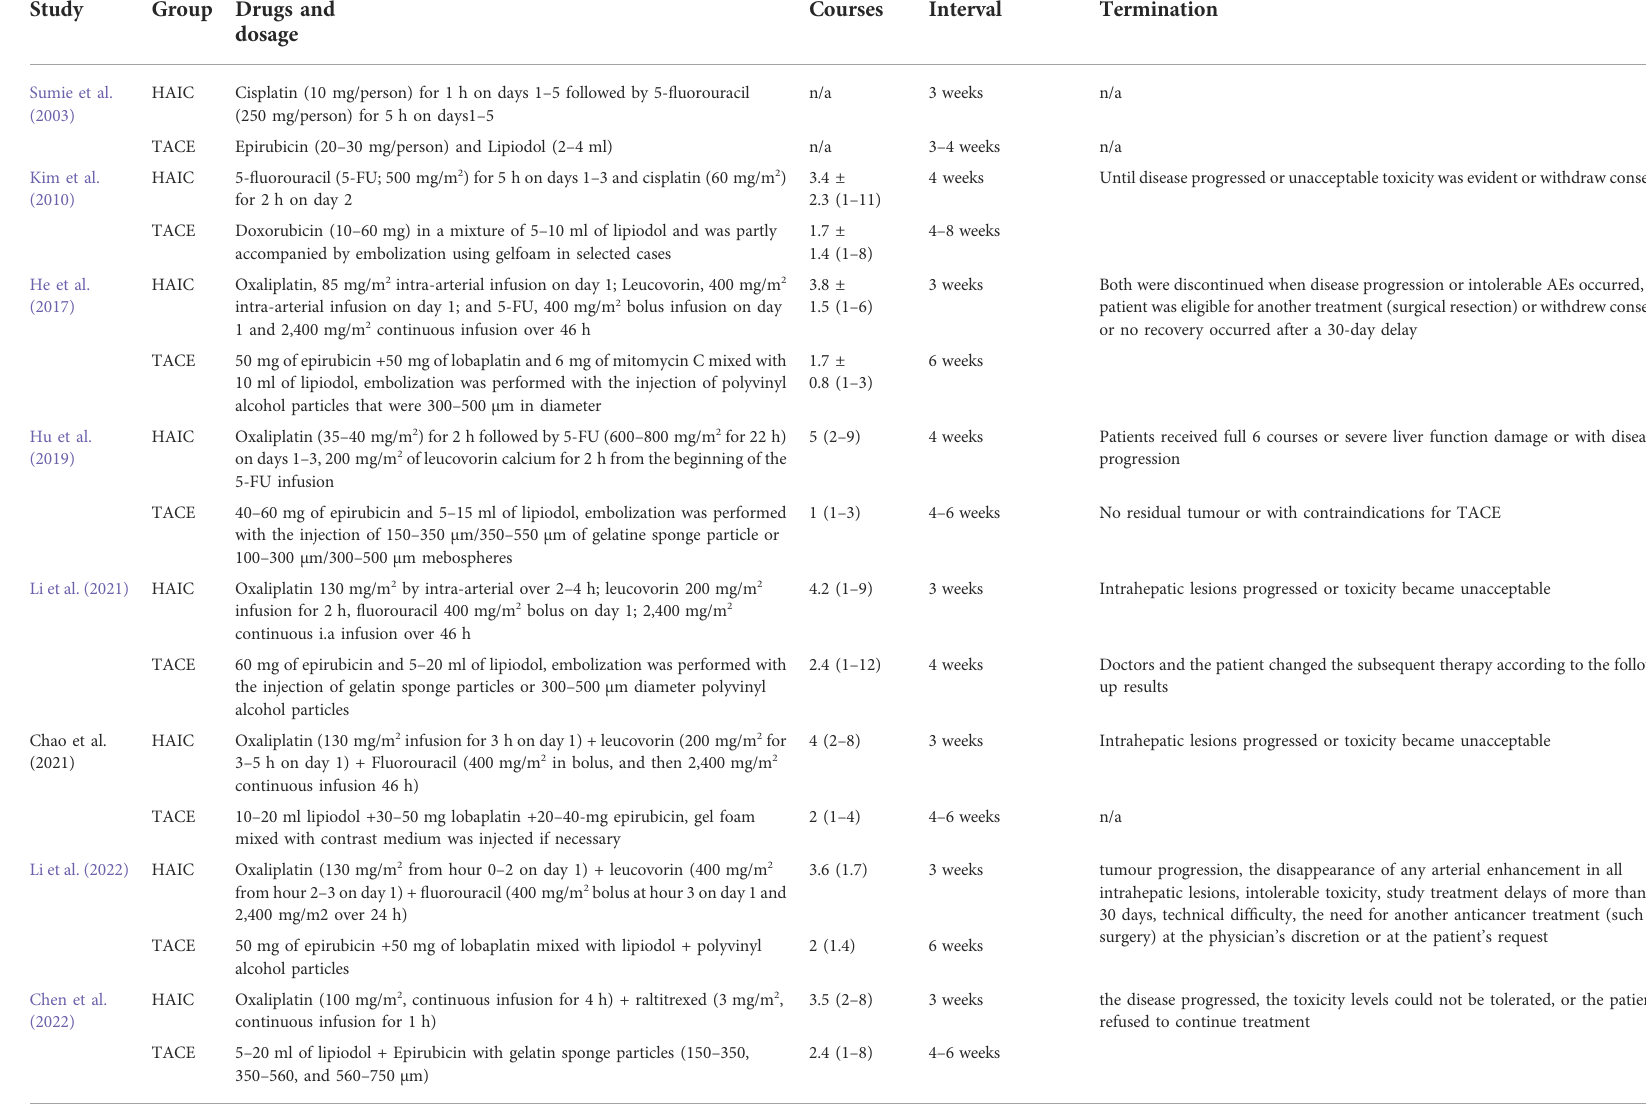
TABLE 2 Intervention details of included